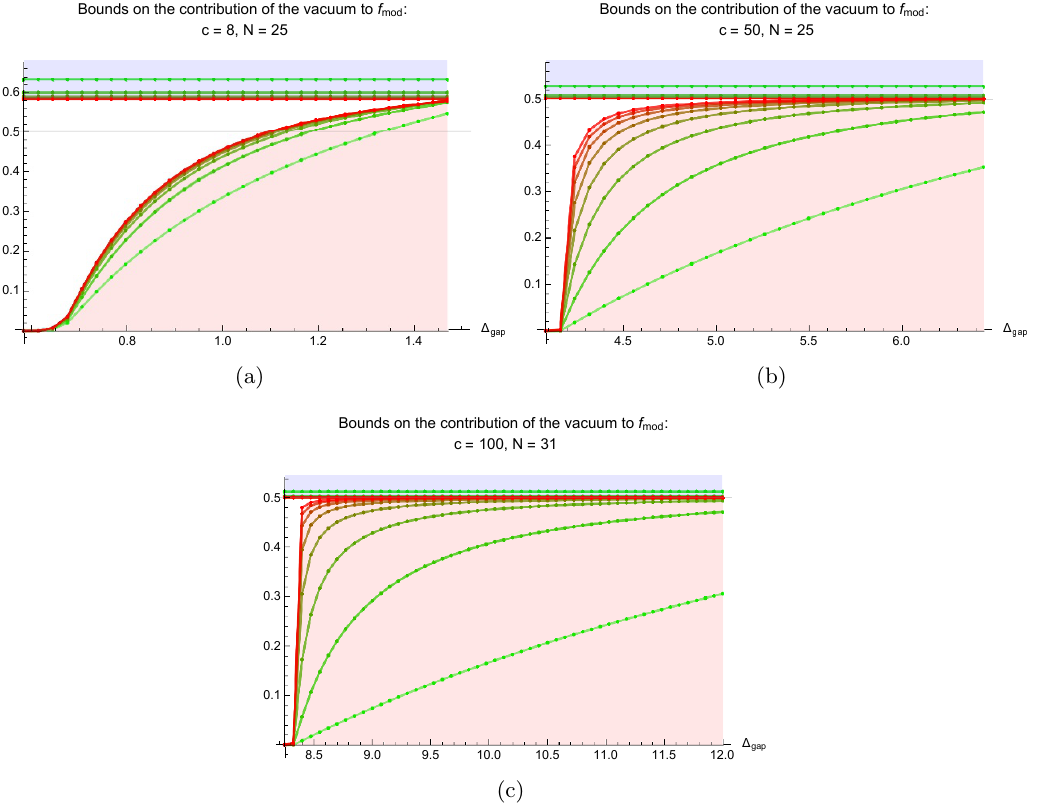
Figure 10 . Bounds on the contribution of the vacuum character to the modular spectral function as a function of the imposed gap in the dimensions of primary operators for c = 8 ; 50 ;